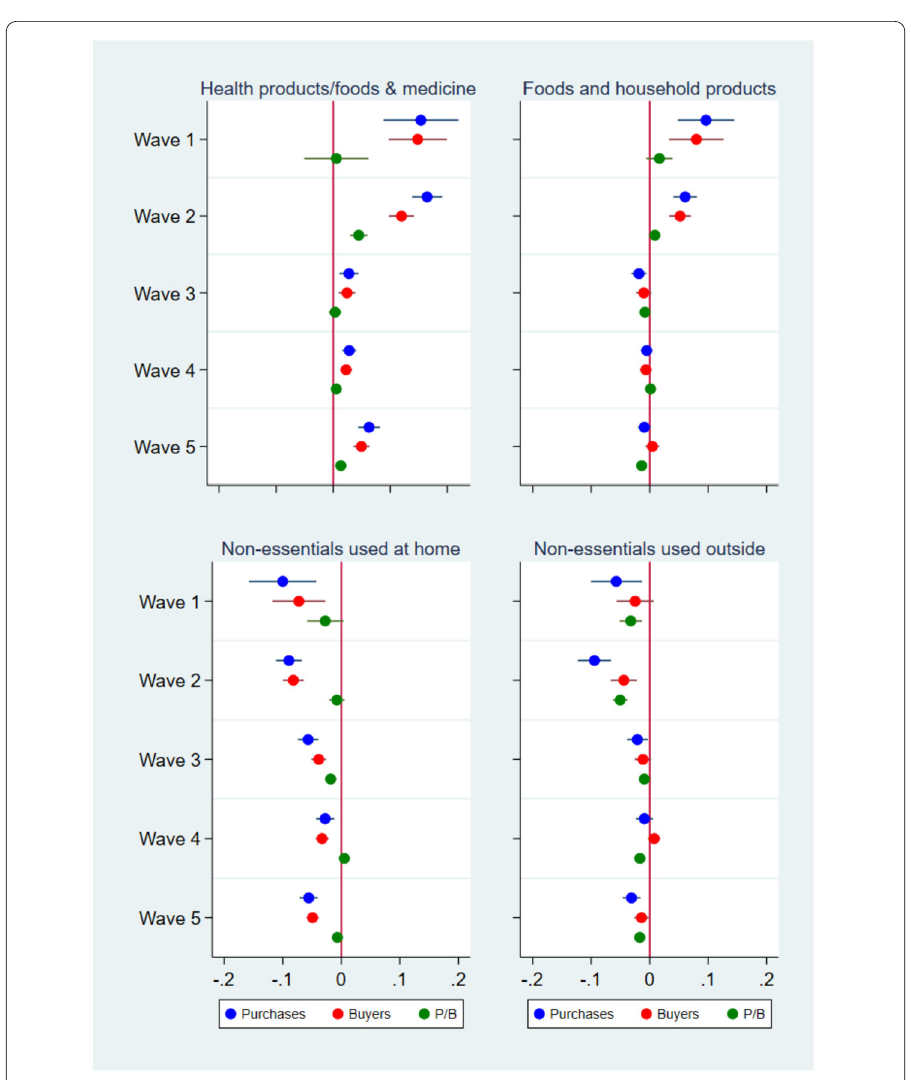
Figure 9 Effects of the Number of COVID-19 Cases on the Purchase Amount, the Number of Buyers, and the Purchase Amount per Buyer by Product Category. This figure illustrates the results from the regressions of the purchase amount, the number of buyers, and the purchase amount per buyer in logs at the prefecture–product–date level by the product category. The dots and lines indicate the coefficients and 95% confidence intervals of the effect of the dummies for 1-4 weeks after a state of emergency (SoE) in different months on the purchase amount (blue), the number of buyers (red), and the purchase amount per buyer (green). In all the regressions, the other independent variables are the dummies for an SoE; the dummies for before an SoE; the number of COVID-19 cases per 1000 persons; the number of neighboring prefectures in an SoE; and the prefecture, product, date, and day-of-the-week fixed effects. The standard errors are clustered at the prefecture and date levels. N = 188,437